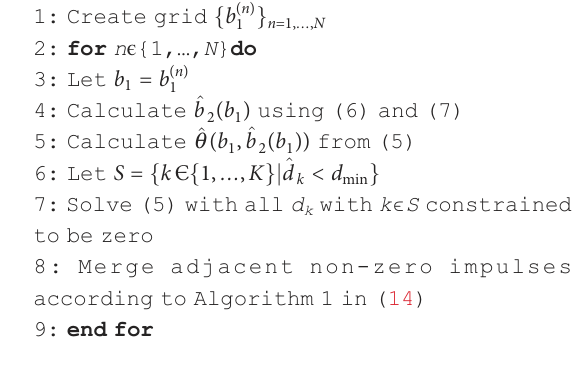
Algorithm 4.1.2, with further details provided in Supplementary Material.